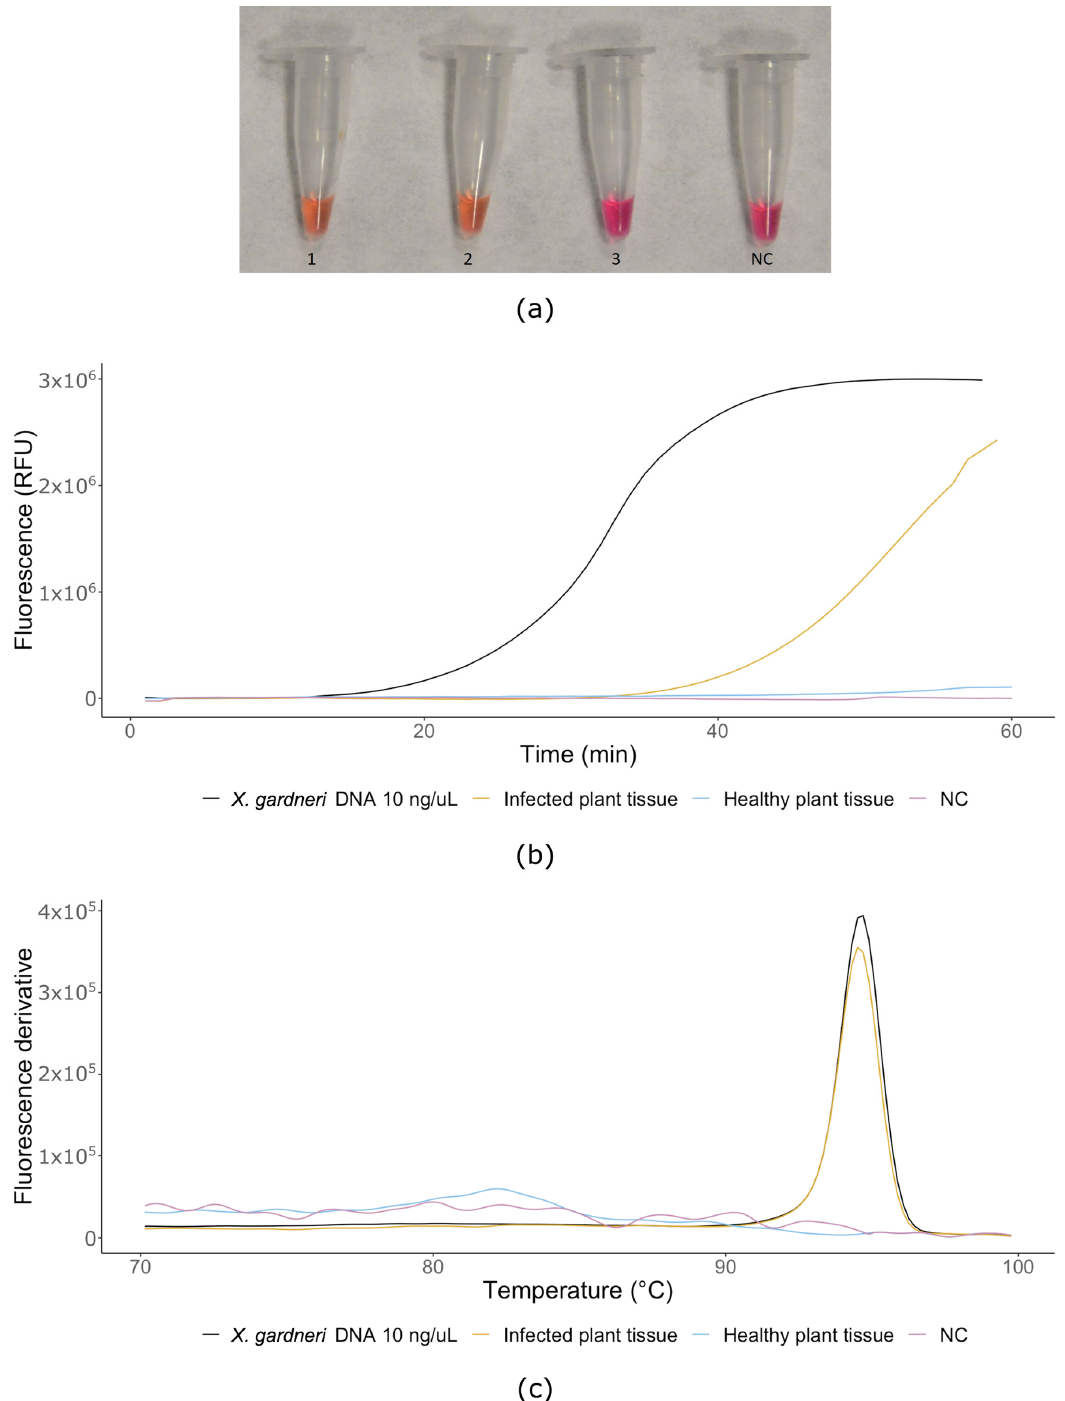
Figure 3. Naturally infected plants: ( a ) colorimetric LAMP assay, 1— X. gardneri bacterial culture DNA (10 ng/ μ L, strain DSMZ 19127), 2—infected plant sample, 3—healthy plant tissue, NC—non-template control (water); ( b ) real-time LAMP in BioRanger TM device; ( c ) melting curves of LAMP products.